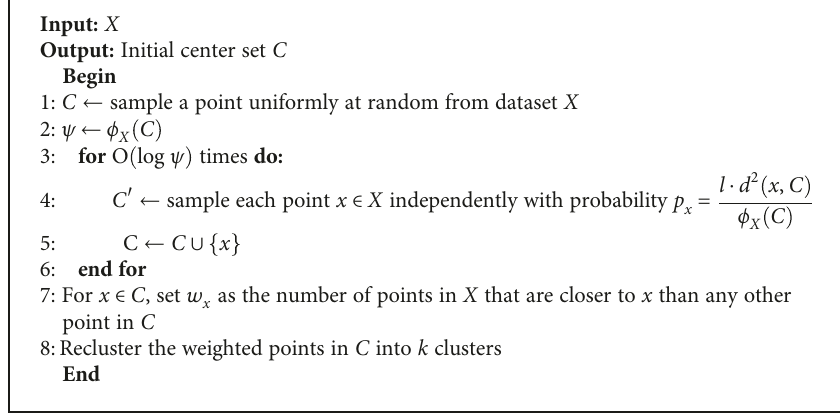
Algorithm 3: ( K -means||